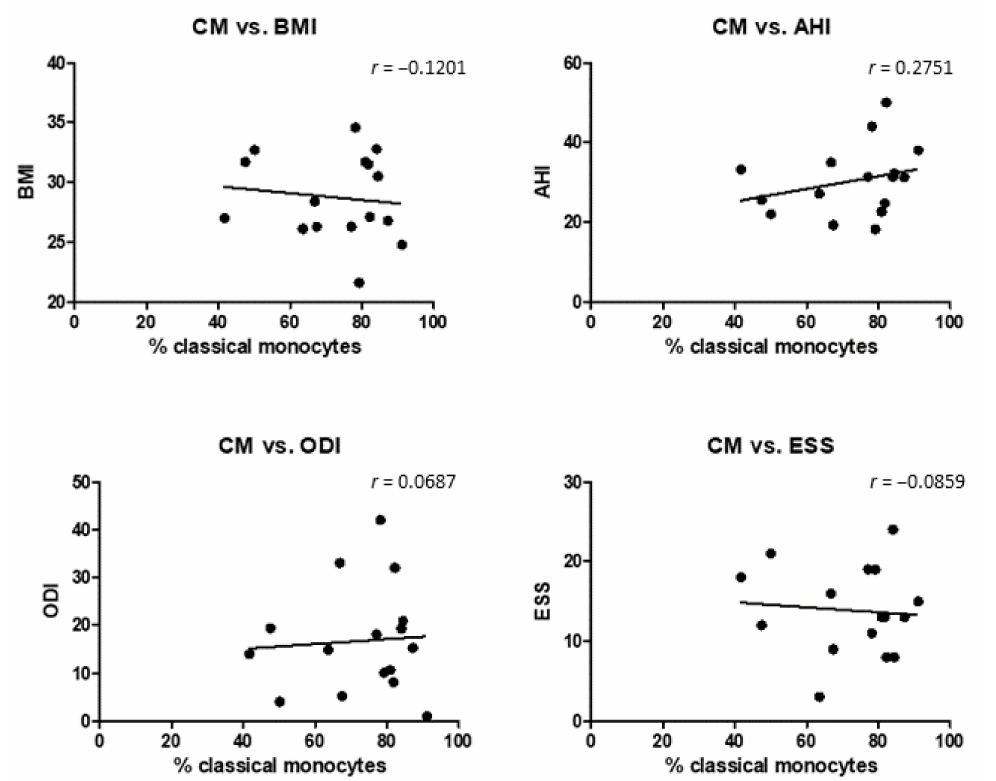
Figure 5. Correlation analysis between different parameters (BMI, AHI, ODI, ESS) measured in OSAS patients. A multivariate progression with the Pearson correlation was carried out. The correlation coefficient (r) is given for each